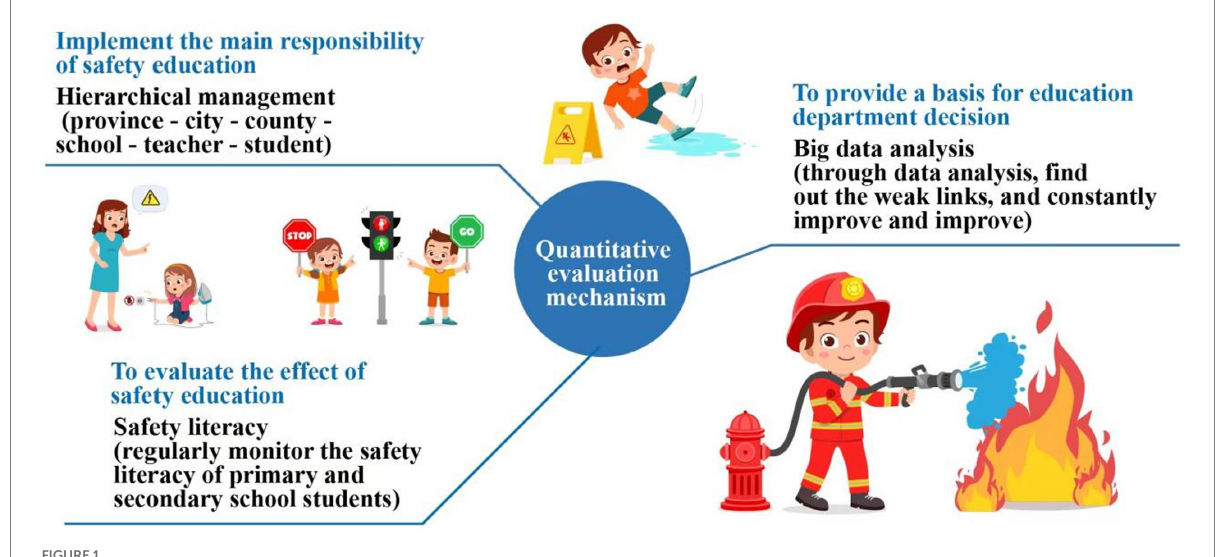
FIGURE 1 Safety education management and supervision